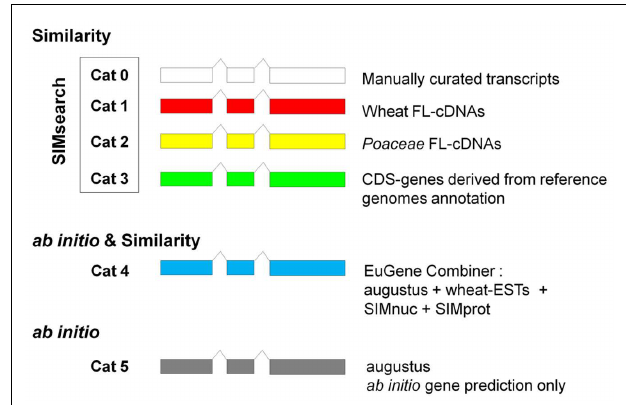
FIGURE 2 | Color coded system established to provide a quality index for the gene annotation inTriAnnot. Six categories (Cat0–Cat5) have been defined depending on the approach and the biological evidences used for the analysis. FL-cDNAs, full-length cDNAs.The SMInuc and SIMprot databanks are described in more detailsTable S2 in Supplementary